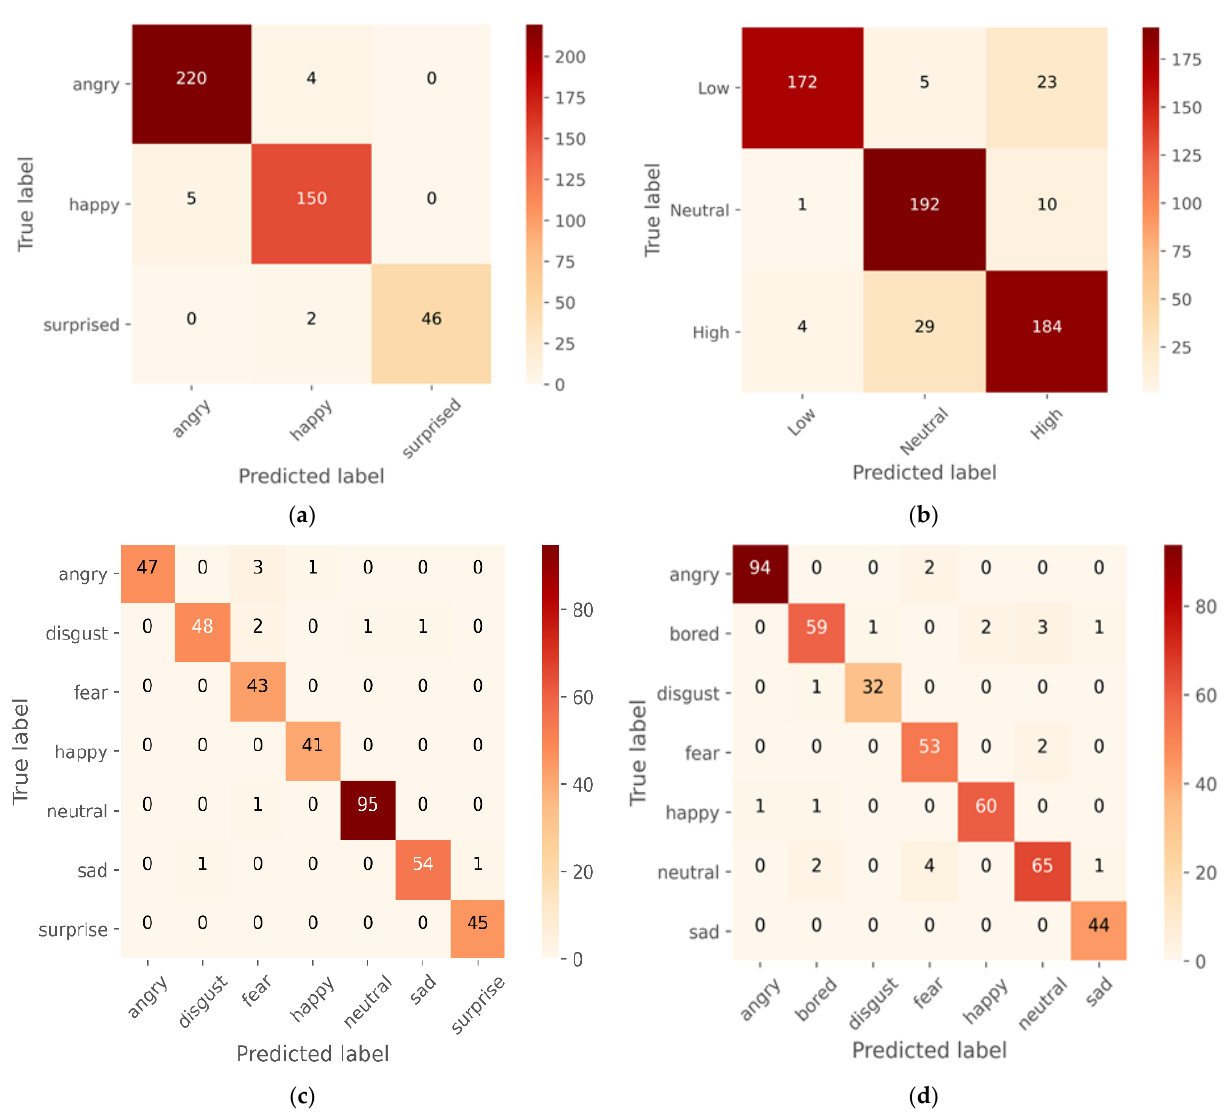
Figure 7. Confusion matrix of 1D CNN with the LSTM attention model for the ( a ) ANAD, ( b ) BAVED, ( c ) SAVEE, and ( d ) EMO-DB datasets.